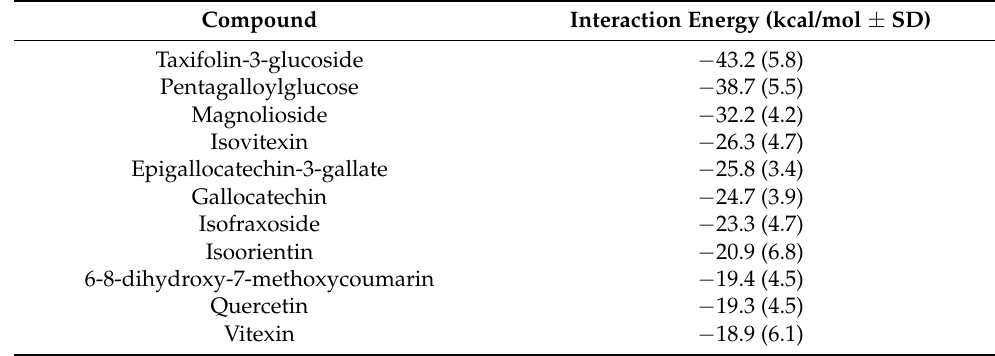
Table 6. Results of MM-GBSA analysis of the Spike- PEL compounds complexes. For each compound, we reported the average interaction energy calculated over the last 30 ns of the